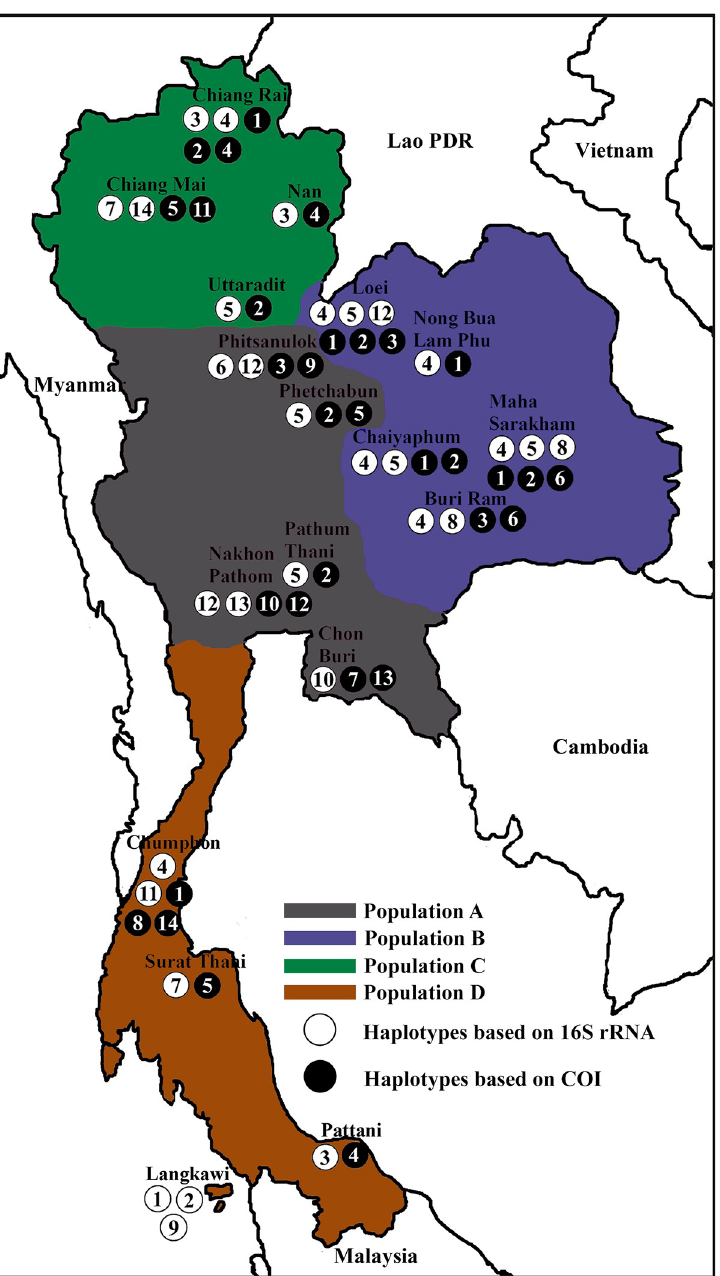
Fig 1. Geographical locations of the 4 populations of C . siamensis in Thailand, with the 14 haplotypes based on the 16S rRNA and COI sequences. Numbers inside the closed and opened circles indicates the haplotype number.